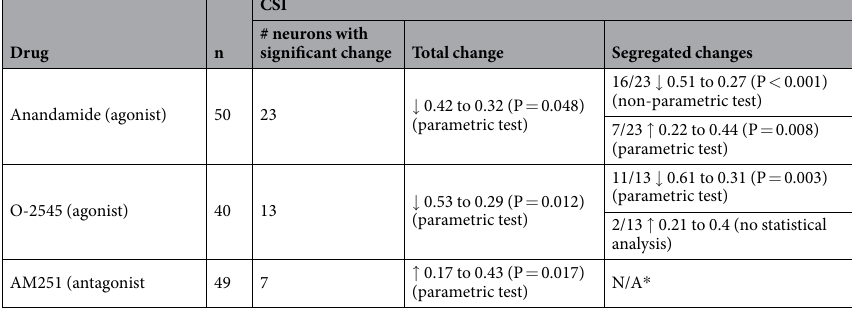
Table 1. Summary of effects of cannabinoid drugs on the CSI. * N/A Does not